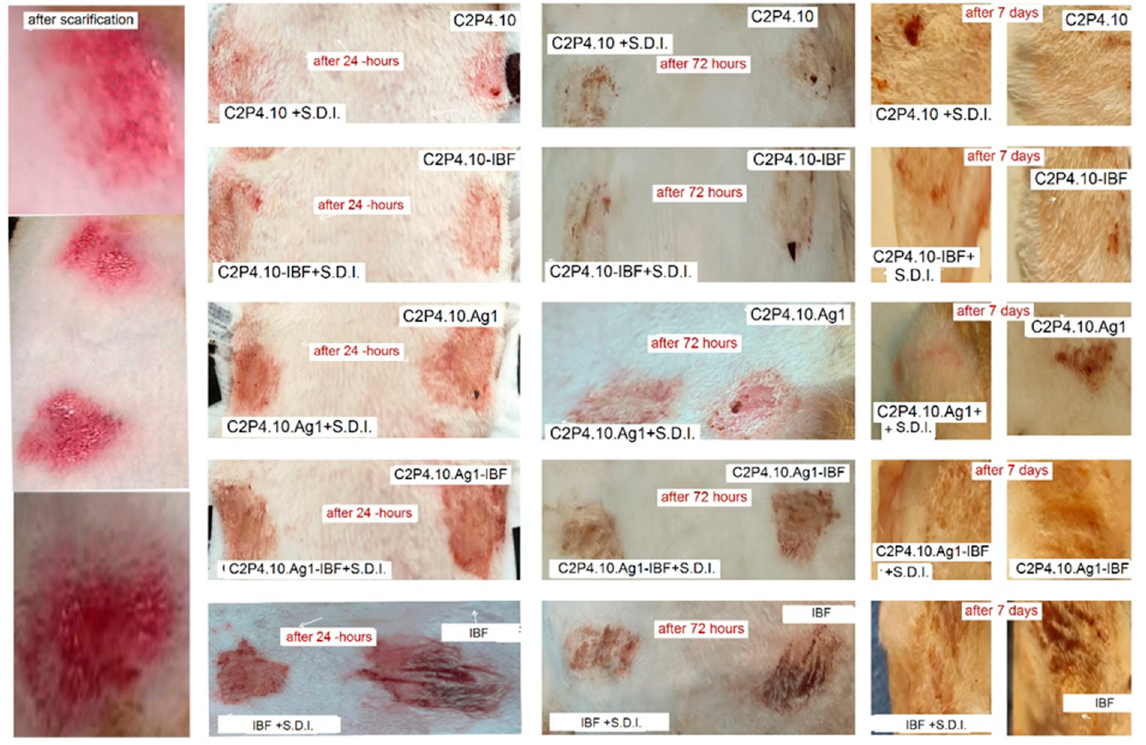
Figure 13. Macroscopic appearance of scarified skin exposed to patches of various drug formulations. A very good evolution can be observed at 7 days in groups treated with formulas C2P4.10.Ag1-IBF simple and C2P4.10.Ag1-IBF +S.D.I. and C2P4.10-IBF and less favorable in those with IBF. S.D.I. (Solution Dermal Irritations).